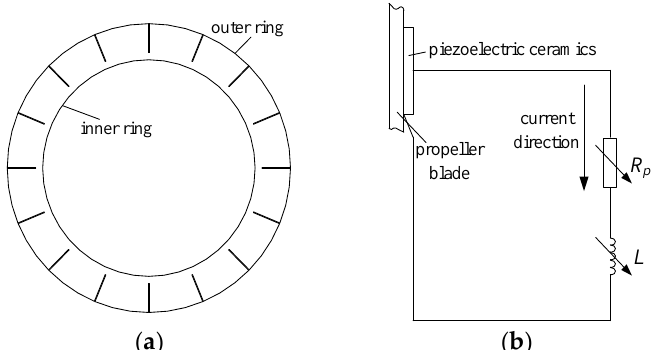
Figure 2. Piezoelectric ceramics and shunt circuit. ( a ) Annular piezoelectric ceramics; ( b ) shunt circuit.